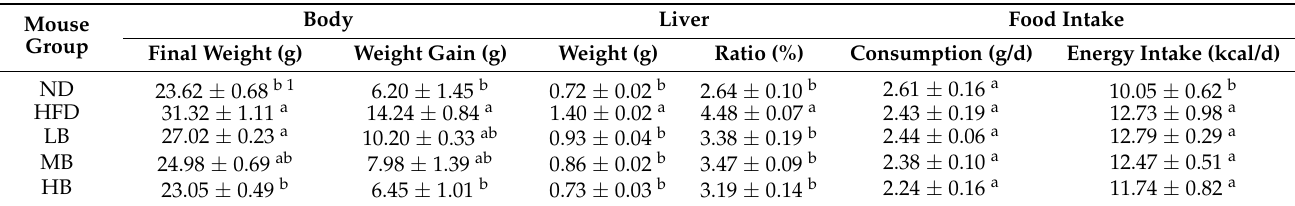
Table 1. Body weight, liver tissue index, and food intake of the